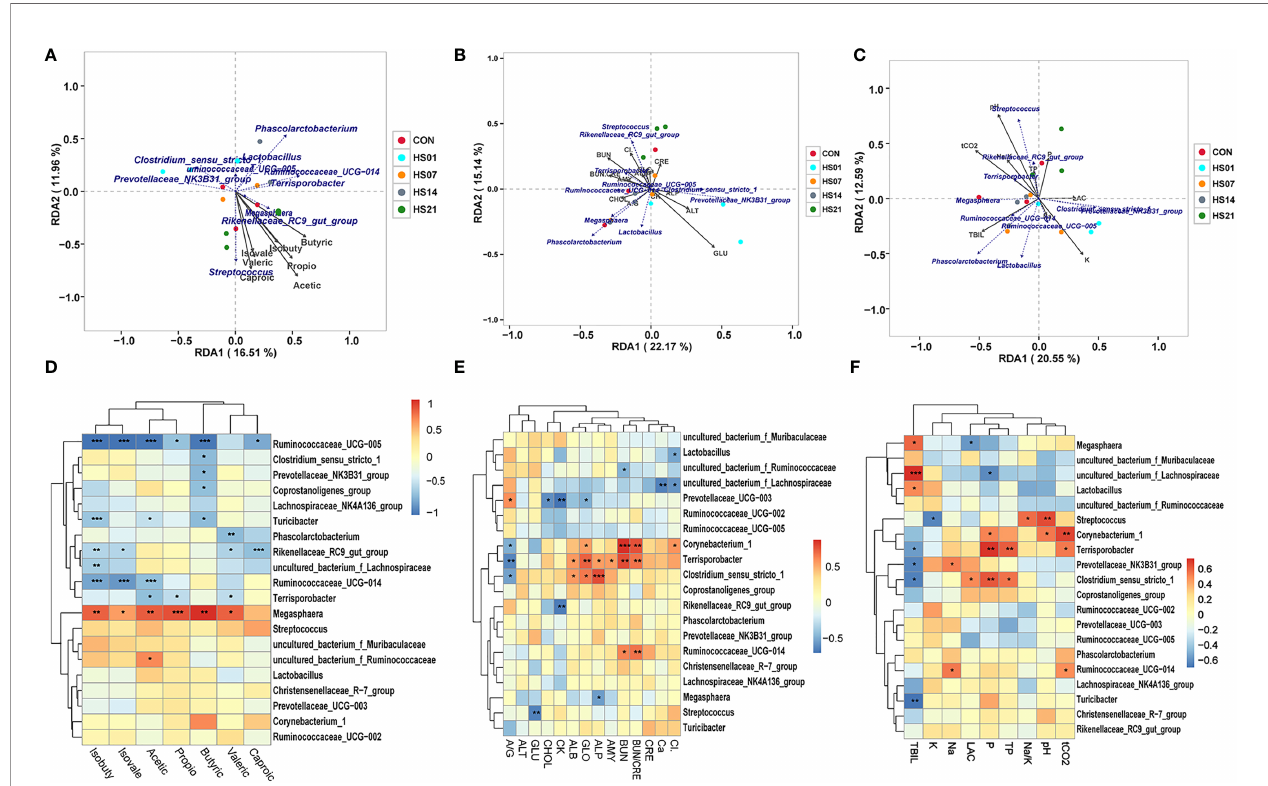
FIGURE 9 | Correlation analysis of microbiome and metabolites. “ * ” means p < 0.05, “ ** ” means p < 0.01, “ *** ” means p < 0.001; (A – C) RDA/CCA correlation analysis of metabolites and microorganisms; (D – F) heat map of metabolites and microbiotas correlation. Sorry, I don ’ t know how to analyze this, can you provide the corresponding